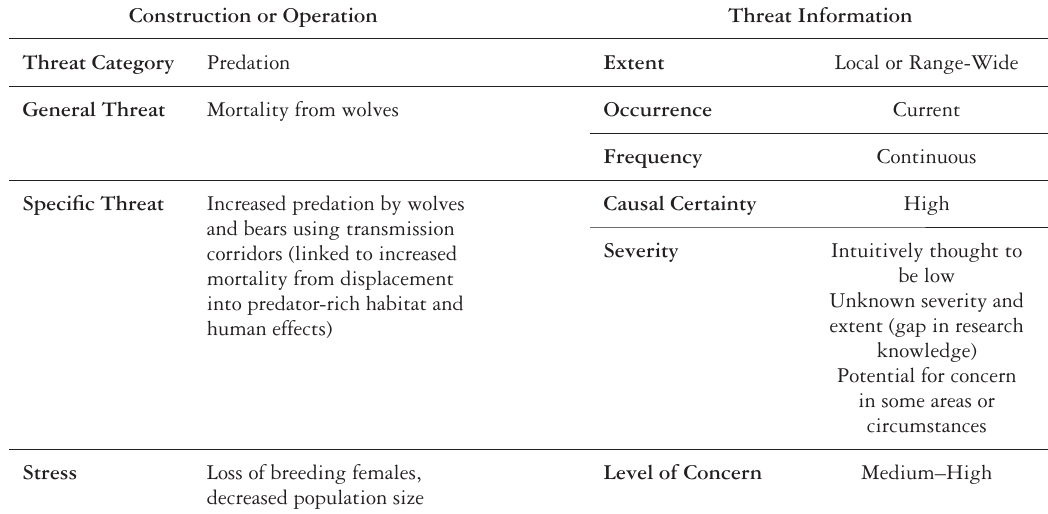
Table 3. Implications of threat categories for Site Selection and Environmental Assessment determined during Manitoba Hydro Boreal Woodland Caribou Workshop addressing boreal woodland caribou predator movement along right-of-ways due to access and habitat change leading to increased mortality.